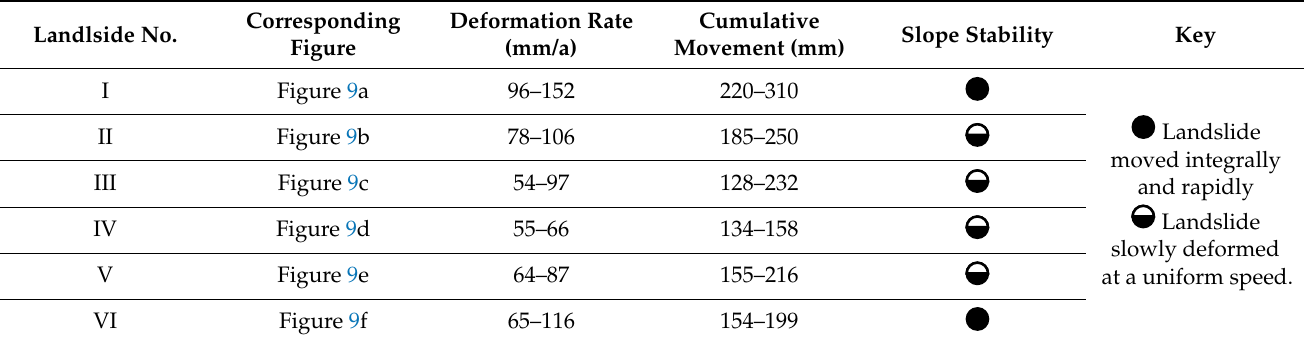
Table 3. Deformation and stability of each landslide in the Lijia Gorge landslide group.